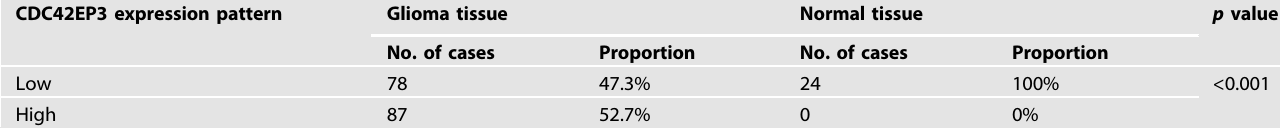
Table 1. Expression patterns of CDC42EP3 in glioma and normal tissues derived from immunohistochemistry analysis. CDC42EP3 expression pattern